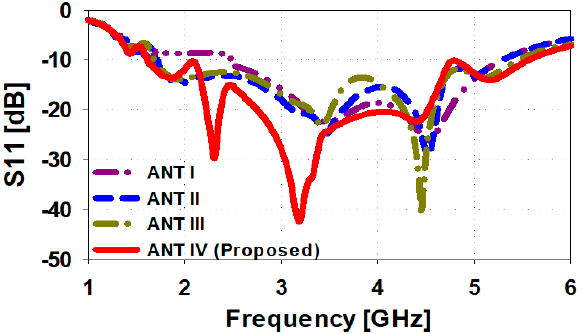
Figure 3. Reflection-coefficient of the circular patch antenna corresponding to the four steps in Figure 2 to realize the proposed unit cell antenna.